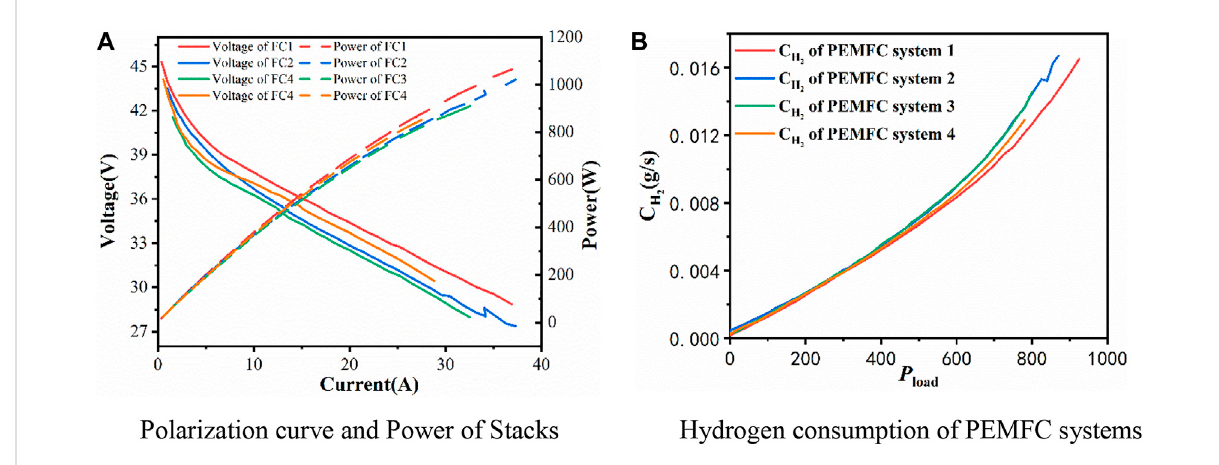
FIGURE 1 PEMFC characteristic curve on experiment data. (A) Polarization curve and power of stacks. (B) Hydrogen consumption of PEMFC